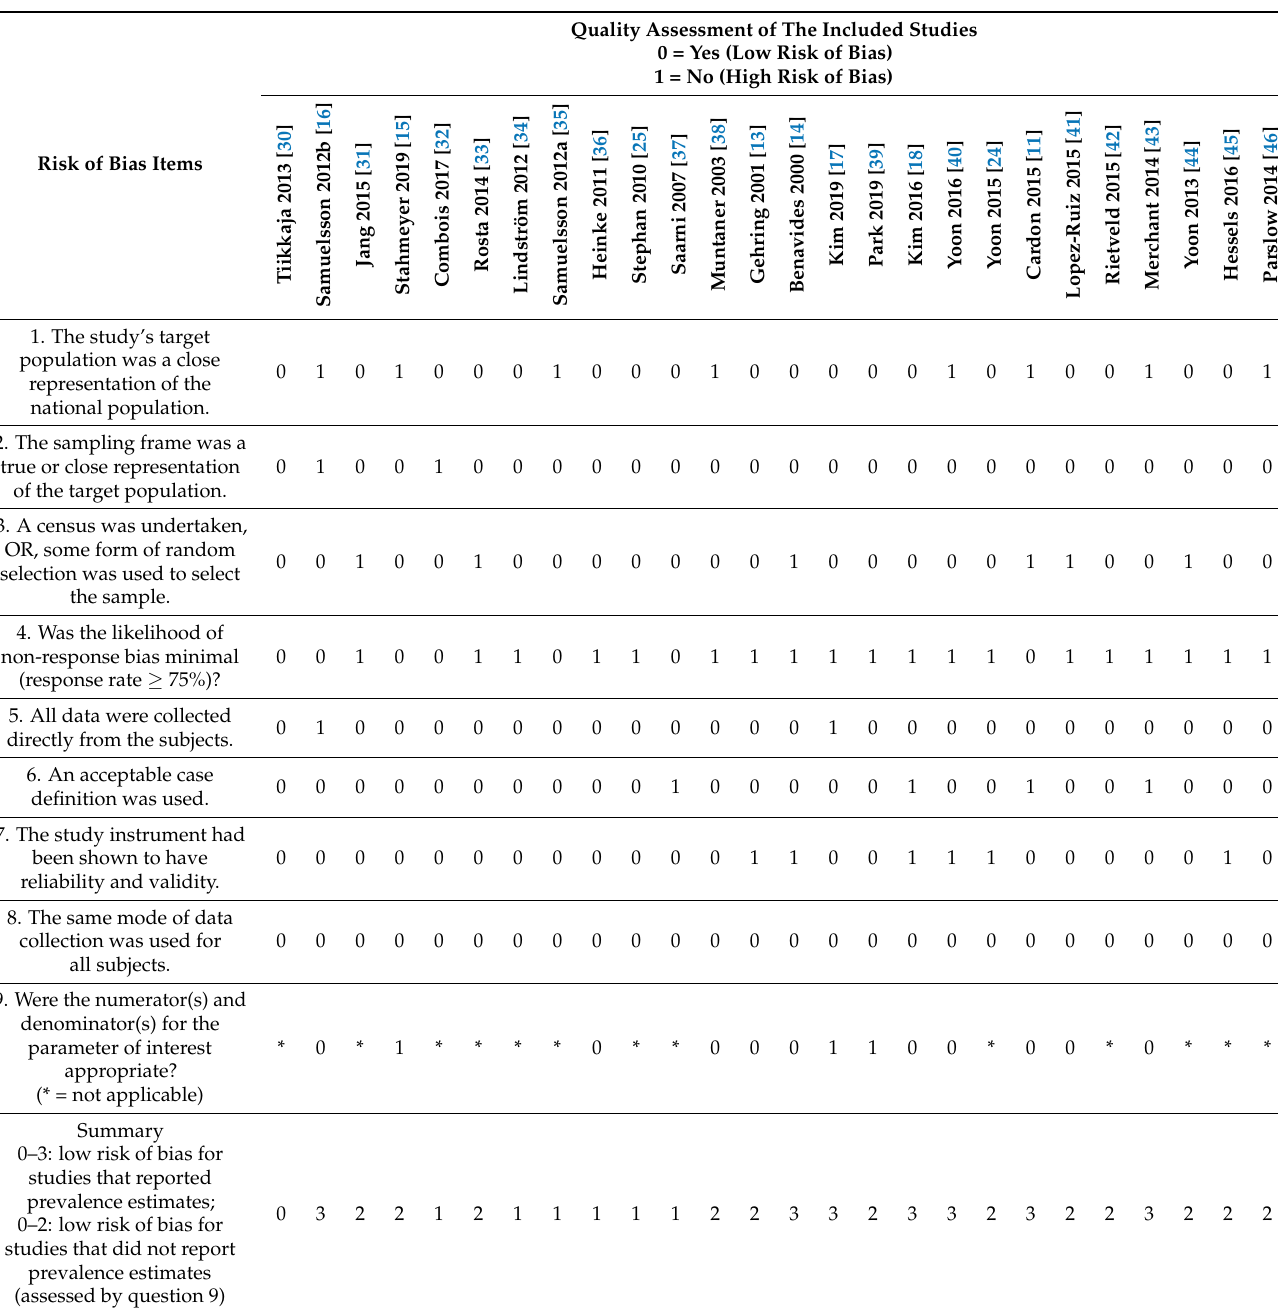
Table 1. Quality assessment by Hoy et al. of the included studies with good quality.